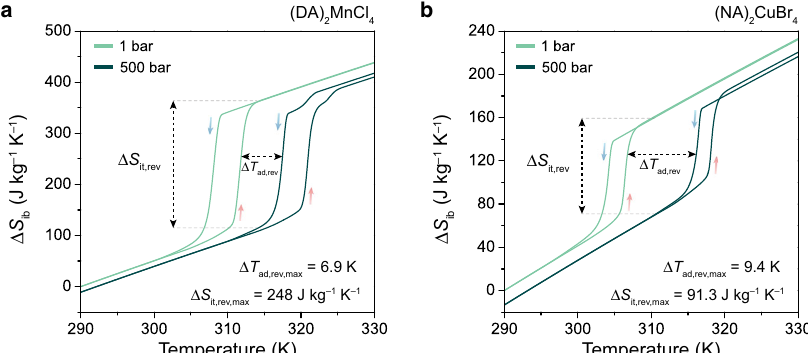
Fig. 6 Reversible barocaloric effects at 500 bar. Isobaric entropy changes ( Δ S ib ) during heating and cooling at ambient pressure and 500 bar are shown for ( a ) (DA) 2 MnCl 4 and ( b ) (NA) 2 CuBr 4 . Note that the Δ S ib curves include contributions from the heat capacity. The area between Δ S ib ( T , 1 bar) heating and Δ S T , 500 bar) Δ S ib ( cooling curves denotes the temperature range over which both reversible isothermal entropy changes ( it,rev ) and reversible adiabatic temperature changes ( Δ T ad,rev ) are value of 70 bar at 311 K (Fig. 3c, Supplementary Fig. 18, heat fl ow signals over three cycles of increasing and decreasing Supplementary Table 11). hydrostatic pressure between 1 bar and 150 bar at 311 K. By comparing the onset pressures for compression-induced exotherms and decompression-induced endotherms, we were able to directly measure a pressure hysteresis of 62 ± 4 bar for (DA) 2 MnCl 4 , which is in excellent agreement with the predicted